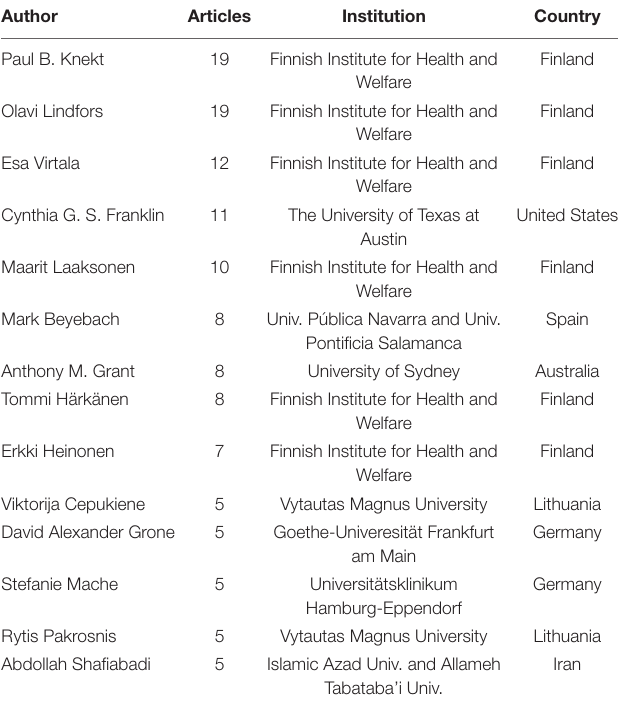
TABLE 3 | Journals, papers published in WEIRD and non-WEIRD countries and presence in